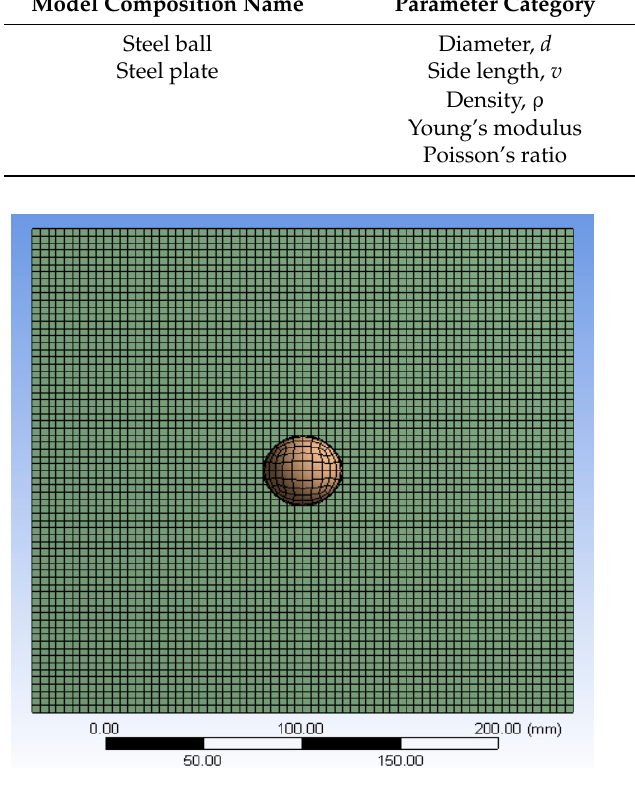
AB Figure 5. Distribution of impact positions and detection positions. Step 1: Select impact position 1, apply 1 m/s, 1.5 m/s, 2 m/s, 2.5 m/s, and 3 m/s on the steel ball to impact the steel plate, obtain the relevant data of stress and impact force at the detection point, and establish the correspondence between impact force and stress wave. Step 2: Move the impact point to position 2 and position 3 in turn, and set the steel ball to impact the steel plate at 1 m/s, 1.5 m/s, 2 m/s, 2.5 m/s, and 3 m/s, respectively. Again, in our experiment, the relevant data was recorded and data analysis and processing were performed. Position 1 Position 2 Position 3 C